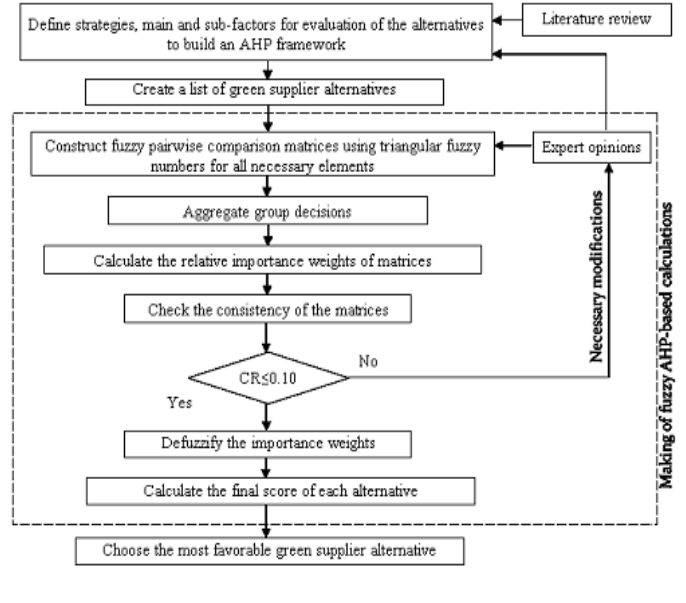
Fig. 2. Proposed evaluation